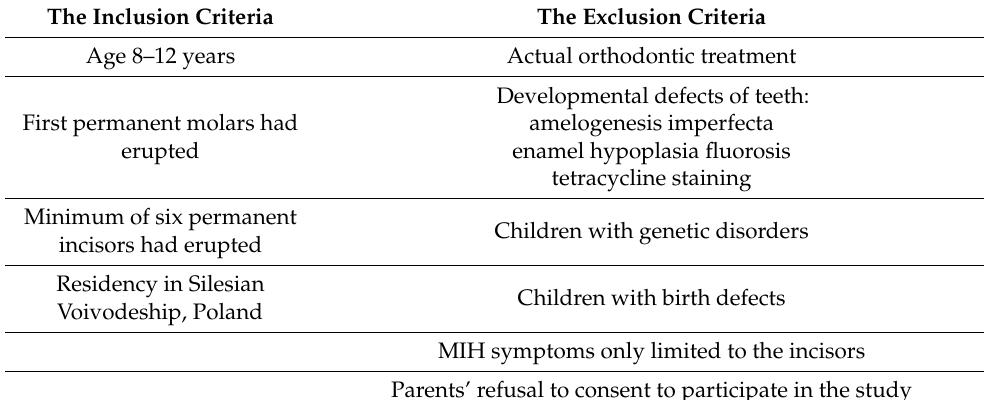
Table 2. The inclusion and exclusion criteria of the pilot